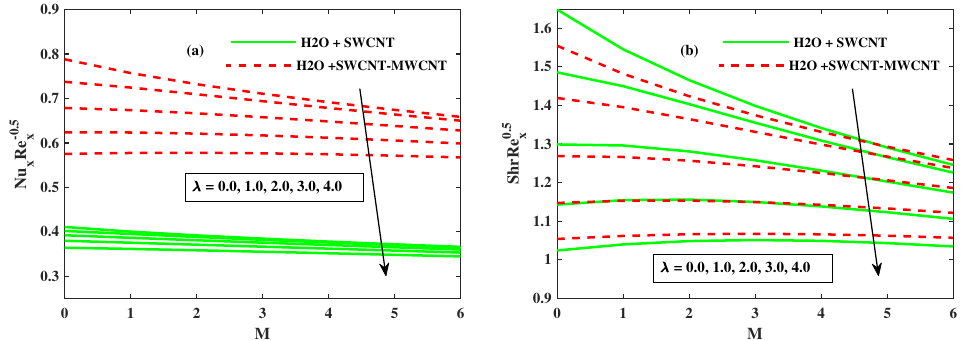
Figure 10. Effect of λ and M on Cf x · Re x 0.5 and Cf y · Re x 0.5 .